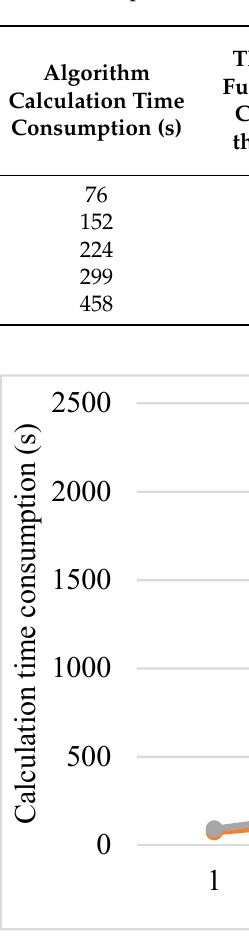
Table 16. Comparison table of algorithm efficiency and accuracy for different cases.